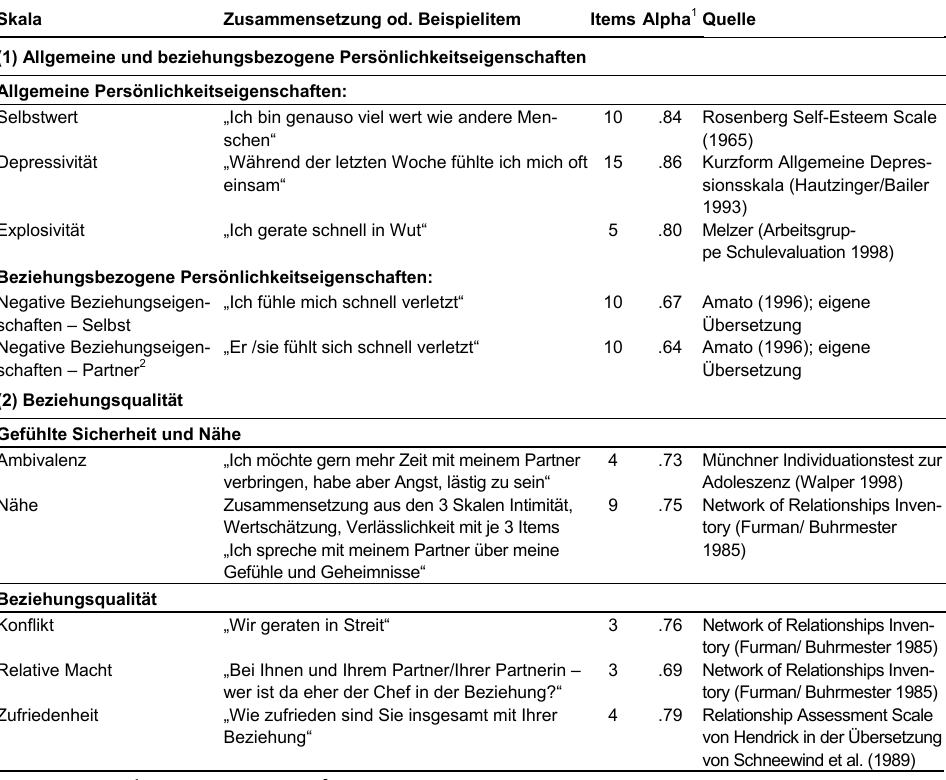
Tabelle 1 : Herangezogene Skalen aus dem